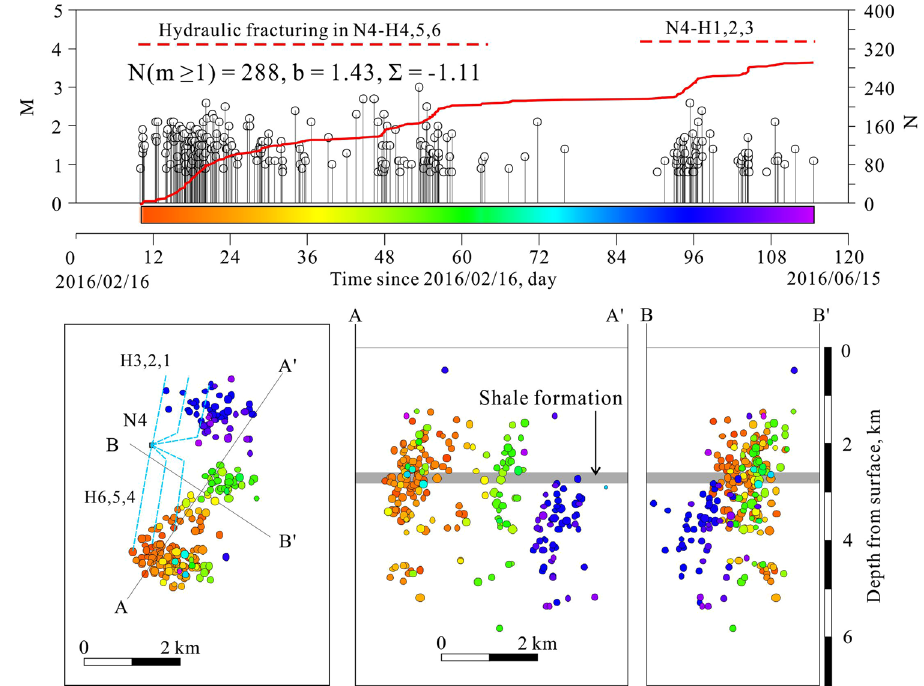
Figure 4. Detailed view of seismic cluster associated with well pad N4. The earthquake hypocenters are colored by date. Injection time window for well pad N4 is shown for comparison. The upper plot shows magnitudes and cumulative events, while the lower plots show map and vertical section views of earthquake distributions after double difference relocation. The calculated seismogenic index ( Σ ) is − 1.11. The blue dashed lines in the map plot indicate traces of horizontal wells used for hydraulic fracturing